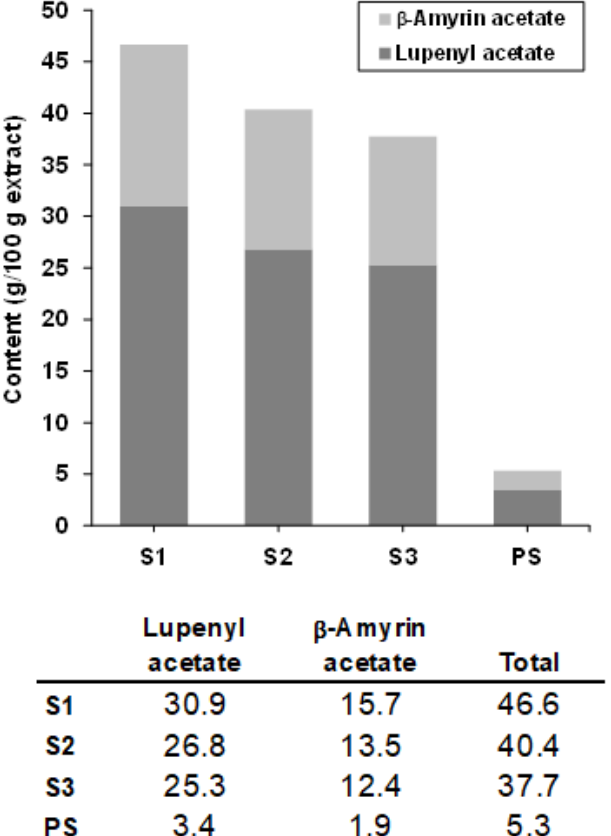
Figure 2. Content (g of compound/100 g of extract) of lupenyl acetate and b-amyrin acetate from S1, S2, S3, and PS supercritical extracts from MB.